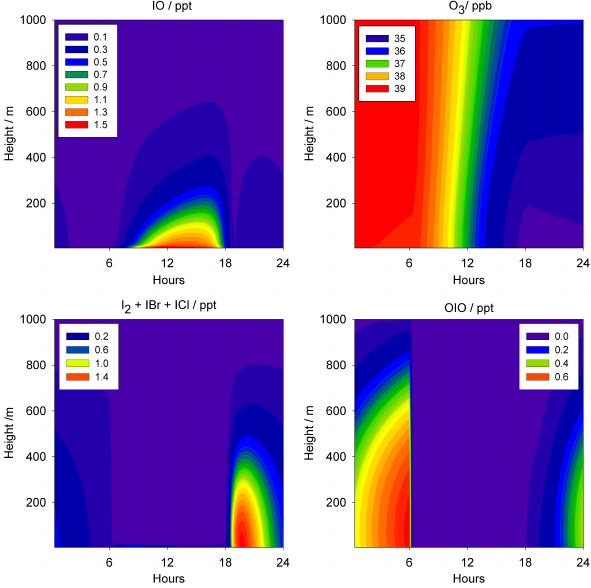
Fig. 4. Predicted profiles of IO, O 3 , (I 2 +IBr+ICl) and OIO at Cape Verde using an extra I 2 flux in addition to measured halocarbon fluxes. The IO mixing ratios are seen to peak at 1.5pmolmol − 1 at the height of measurements and are in good accord with the observed average of ∼ 1.5pmolmol − 1 . The predicted O 3 deple- tion is about 4.4nmolmol − 1 over one day, while the predicted I 2 and OIO values are under the detection limit of the DOAS instru- ment (I 2 − 15pmolmol − 1 , OIO − 10pmolmol − 1 ) . The model is initialised at midnight and the IO, OIO and (I 2 +IBr+ICl) data from 24–30 h has been shifted by − 24 h in order to illustrate the full diurnal cycle. Local noon is at